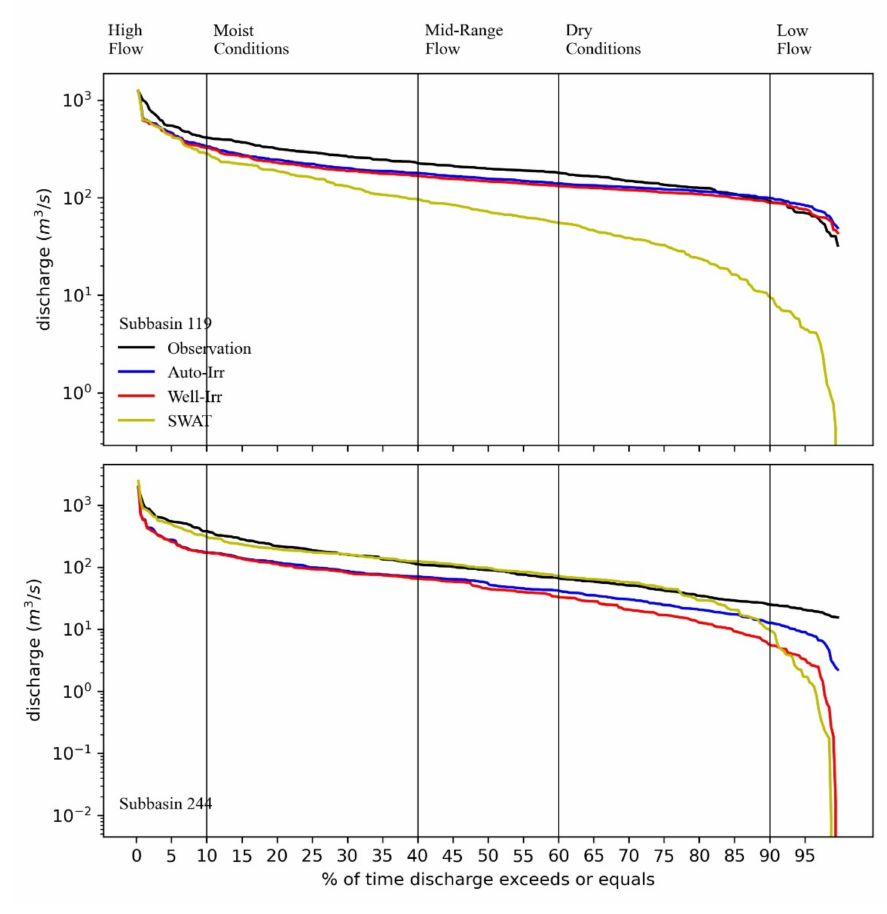
Figure 5. Simulated and observed flow duration curve at the outlets of U.S. Northern High Plains from 1982–2008.